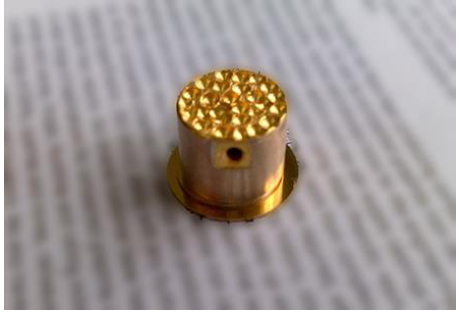
Figure 8. Ultrasonic transducer with a graphite bronze backing on the top.